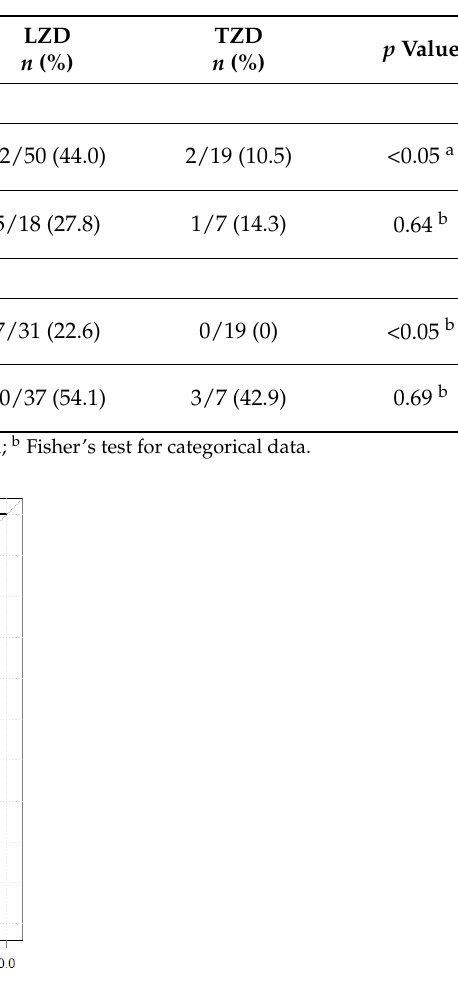
Table 7. Incidence of hyponatremia compared by renal function and albumin.